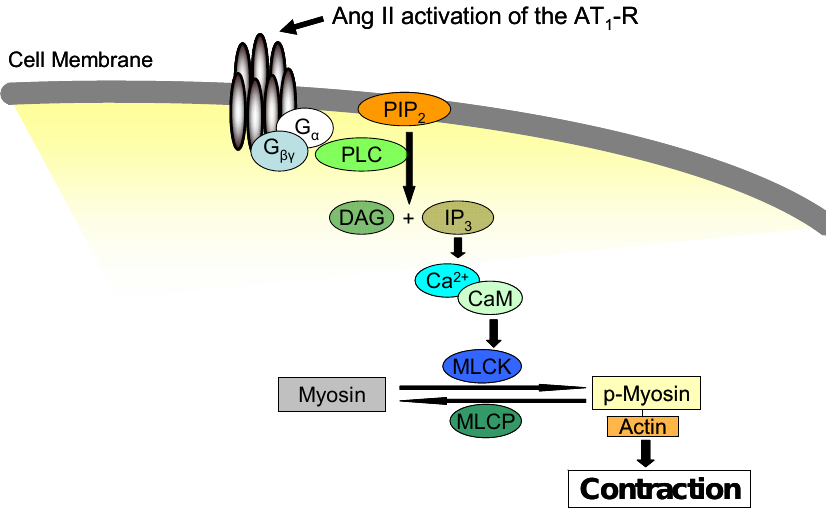
Figure 3. The mechanism by which Ang II mediates vasoconstriction. The binding of Ang II to the AT -R activates the heterotrimeric G protein signaling pathway which leads to 1 phospholipase C (PLC) activation. This releases inositol-1,4,5-triphosphate (IP diacylglycerol (DAG) from phosphatidylinositol 4,5-bisphosphate (PIP receptor on the sarcoplasmic reticulum, allowing for Ca 2+ efflux. Ang II also promotes an influx of external Ca 2+ via calcium release activated calcium (CRAC) channels. Ca 2+ binds to calmodulin and activates myosin light chain kinase (MLCK), which phosphorylates the myosin light chain and enhances the interaction between actin and myosin, resulting in enhanced